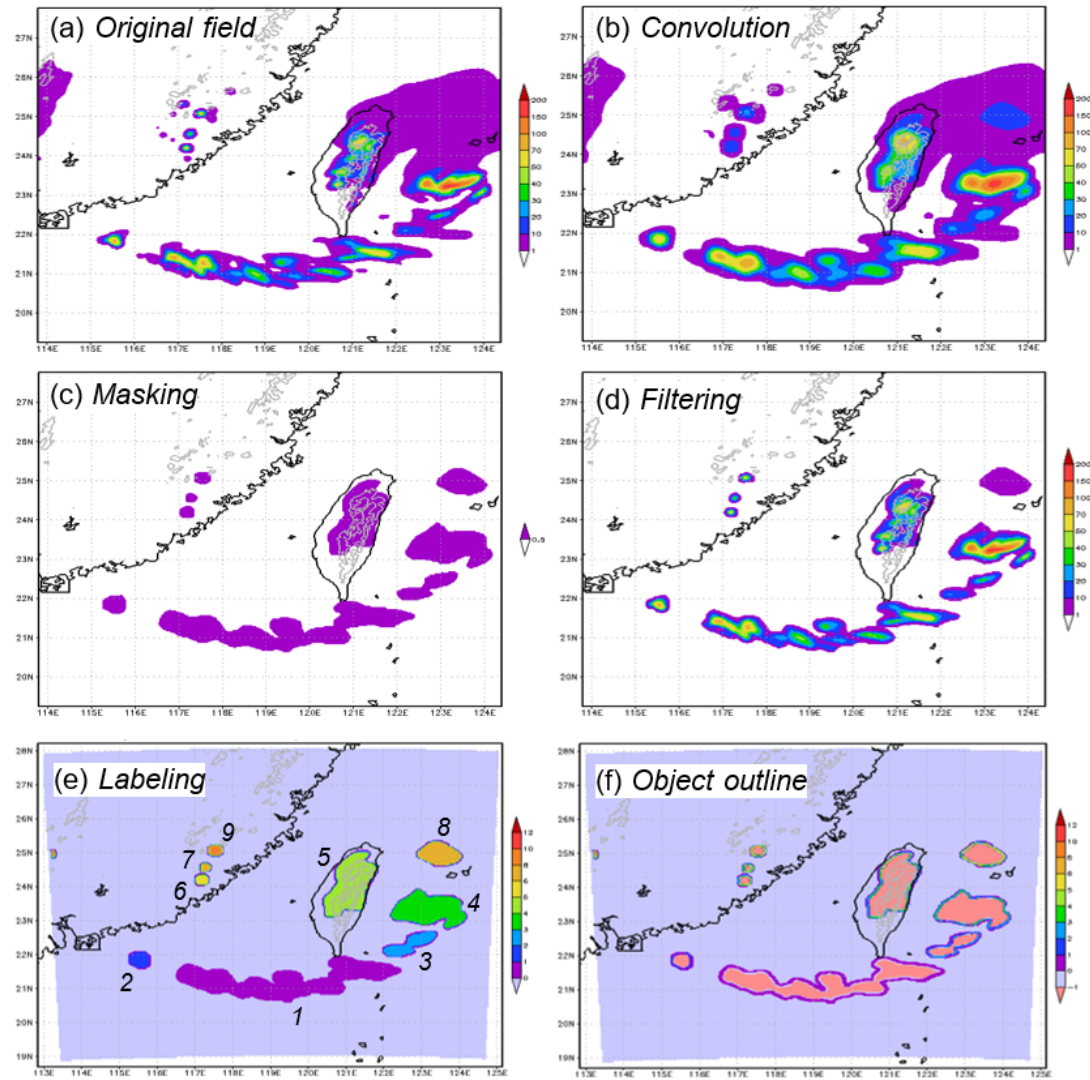
Figure 1. An example of 3-h quantitative precipitation forecast (QPF) (mm) by Cloud-Resolving Storm Simulator (CReSS), initialized at 12:00 UTC 30 May and valid for 06:00–09:00 UTC 31 May 2008, to show the identification process of rainfall objects in this study. ( a ) Original 3-h accumulative rainfall field, and subsequent fields after ( b ) convolution (smoothing), ( c ) masking using a threshold of 10 mm (per 3 h), ( d ) filtering to restore values only inside objects, ( e ) labeling, or assignment of object identification (ID) numbers (as depicted), and ( f ) boundary identification of objects. In the final step of ( f ), for the purpose of differentiation, grid points along the boundary of an object are assigned its ID number, and those inside it are assigned the minus of its ID number. In ( e,f ), the colored region shows the model domain (also the verification domain).